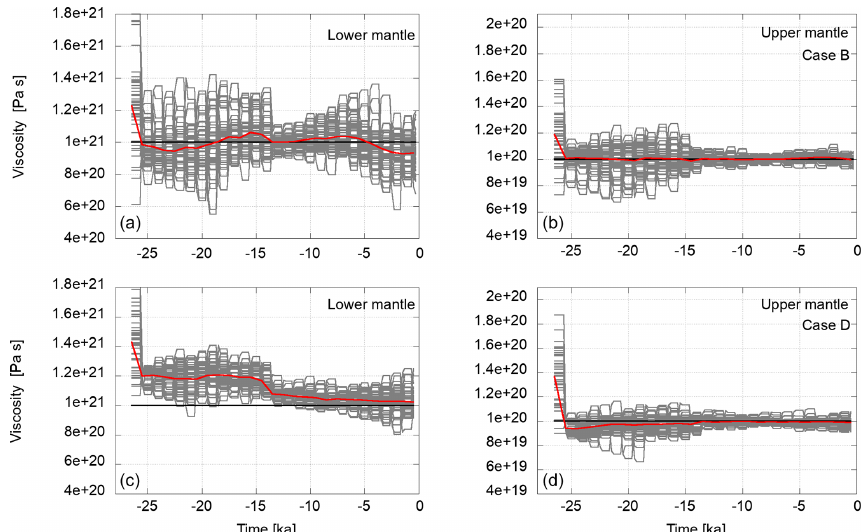
Figure 8. Variations in the viscosity in the course of the assimilation in the lower mantle (a, c) and the upper mantle (b, d) for scenario two (test Cases B and D; from top to bottom) in grey. The flat segments represent the viscosity values of an ensemble member during the forecast phase. When observations are available, a model state may be resampled and perturbed. This changes the viscosity values as shown. The horizontal black lines represent the viscosities of the reference experiment towards which the ensemble mean is expected to converge. The red lines are the weighted ensemble means. For the initial value, all members are weighted equally. Thereafter, they are weighted by the likelihood of the observations given the current member model state.